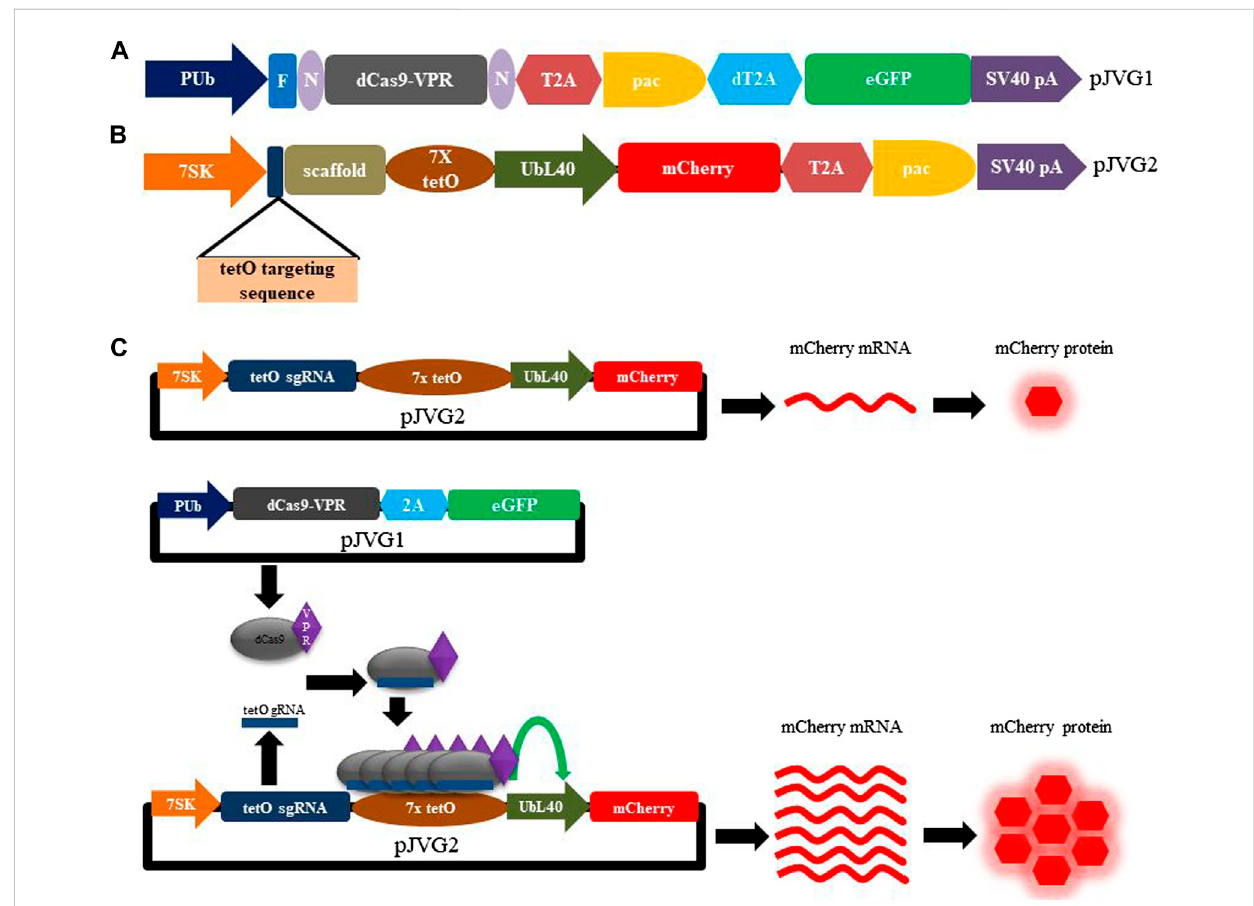
Design of the dCas9-VPR assay plasmids and functional validation of CRISPRa activity in Aedes cells. Schematic diagram showing the design of pJVG1 (A) and pJVG2 (B) plasmids. In pJVG1, the RNA polymerase II promoter PUb regulates the expression of dCas9-VPR, puromycin acetyltransferase (pac) and eGFP which are separated by 2A peptides (T2A and dT2A). The pJVG2 plasmid contains dual expression cassettes wherein the tetO targeting guide RNA and scaffold sequences are transcribed by the RNA polymerase III promoter 7SK while the mCherry and puromycin acetyltransferase (pac) genes, separated by the T2A peptide encoding sequence, are under the control of RNA polymerase II promoter UbL40. Seven copies of the tetracycline operator (tetO) sequence is appended at the 5 ′ end of the UbL40 promoter to facilitate dCas9-VPR recruitment. (C) Overview of the CRISPR activation assay using dCas9-VPR in Aedes cells. The assay consists of transfecting either pJVG2 plasmid alone or together with pJVG1 plasmid. In absence of plasmid pJVG1, the mCherry mRNA is produced from plasmid pJVG2 at the basal level by the UbL40 promoter which is translated to the corresponding red fl uorescentprotein. However, co-transfection ofpJVG1 and pJVG2 plasmids leads to formation offunctional dCas9-VPR-tetO guide RNA complexes which are recruited to the tetO sequences located upstream of the UbL40 promoter resulting in an increased transcriptional activity of the promoter. This results in an increased production of mCherry mRNA and protein which is quanti fi ed by RT-qPCR and fl ow cytometry analysis, respectively. N, NLS sequence, F, FLAG epitope tag, pA, polyadenylation